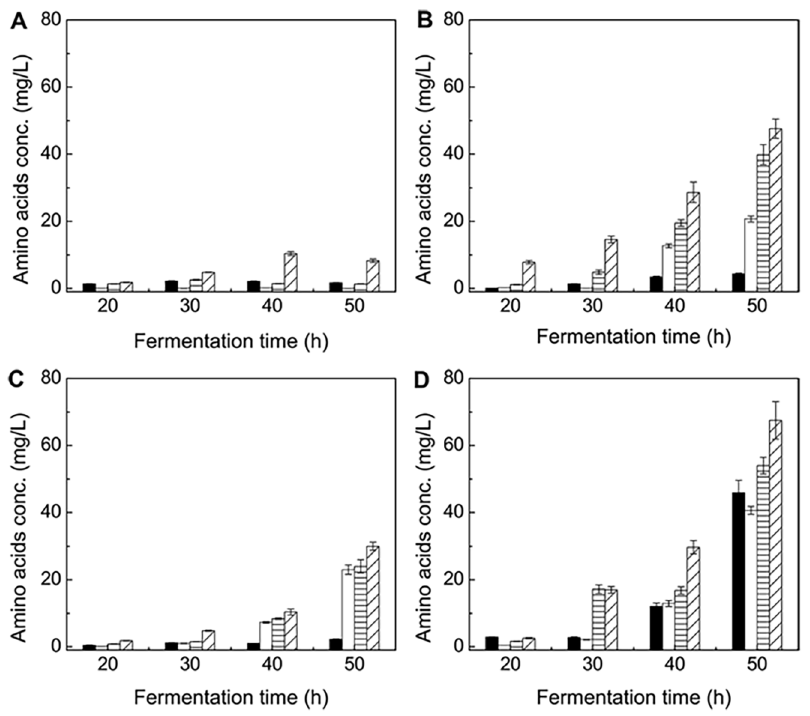
Fig 2. Amino acids secretion patterns with different operation strategies. (A) ABE fermentation by C . acetobutylicum (control, case #a). (B) ABE fermentation by C . acetobutylicum with exogenous butyrate addition (case #b). (C) ABE fermentation by co-culturing C . acetobutylicum / S . cerevisiae (case #c). (D) ABE fermentation by co-culturing C . acetobutylicum / S . cerevisiae in coupling with exogenous butyrate addition (case #d). Black: lysine; white: methionine; horizontal shadow: phenylalanine; slashed shadow: tyrosine. Fig 3D, r NADHBtOH in the case of exogenous butyrate addition (case #b) was about 10 – 50% higher than that of control (case #a) during the solventogenesis phase, the enhanced r NADHBtOH was also responsible for the enhanced butanol concentration and ratio.